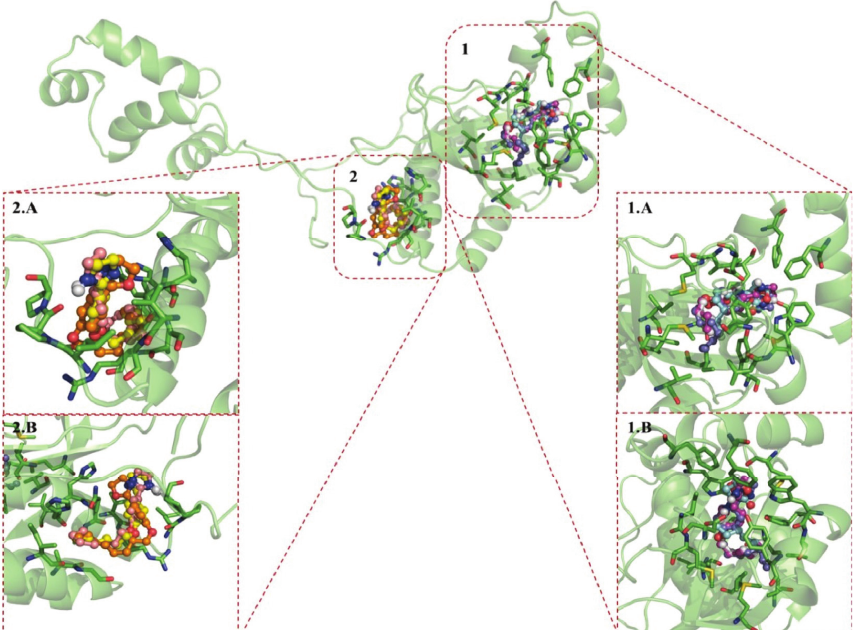
Figure 7: 3D illustration of the interaction of the ligands at two binding sites of the CviR protein, consisting of the orthosteric site and an allosteric site of C 6 -AHL. (1.A) Approach of the overlap of C 6 -AHL, 13 , 16 , and 17 with the amino acid residues of the active site of C 6 -AHL. (1.B) The same approach with a 45 ° rotation. (2.A) Approach of the overlap of 14 , 15 , and 18 with the amino acid residues of the allosteric site. (2.B) The same approach with a 45 ° rotation.